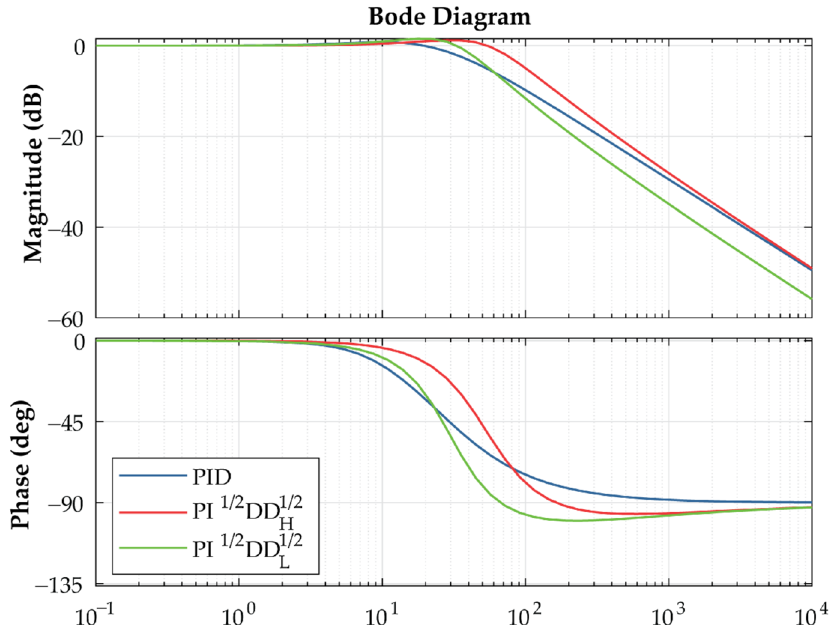
Figure 6. Comparison of the closed-loop system Bode plots: PID (blue); PII 1/2 DD 1/2 H (red); PII 1/2 DD 1/2 L (green).